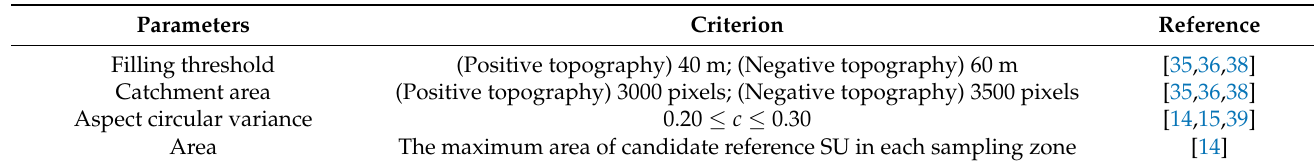
Figure 3. The spatial distribution and examples of reference SUs. ( a ) is the spatial distribution of sampling sites of reference SUs. ( b ) is the relationship between river network density and catchment area threshold. ( c , d ) is the scene photo and slope aspect of reference SU C, respectively. Table 1. Parameters Guide for obtaining reference SUs.